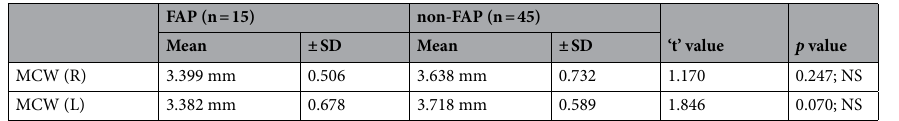
Table 3. Mandibular cortical width in the FAP and non-FAP groups. Results are given as mean ± SD. p-values were determined using Student t test; NS: p > 0.05. L left side, MCW mandibular cortical width, mm millimeters, NS not significant, R right